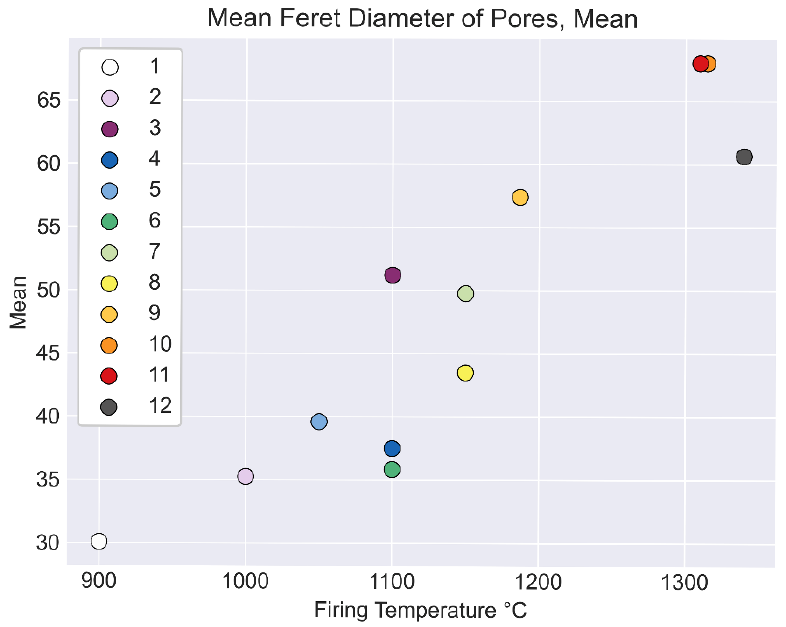
Figure 9. Pore volume-to-surface area increases with firing temperature, indicating more spherical pores at the higher temperatures. Points are mean of 2.